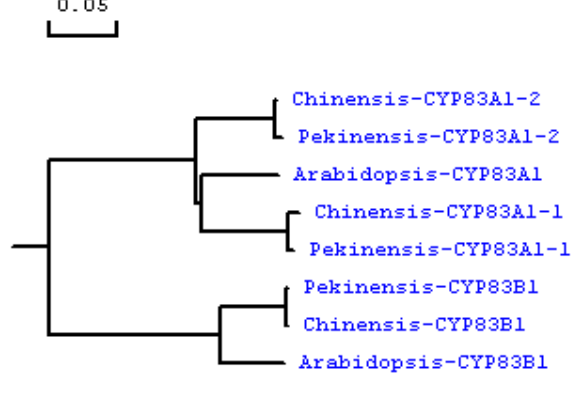
Figure 3. Phylogenetic tree of the cDNA sequences of the plant glycosyltransferase superfamily. GenBank accession numbers are: Arabidopsis thaliana CYP83A1 (NM117451), Arabidopsis thaliana CYP83B1 (NM119299), Brassica pekinensis CYP83A1-1 and CYP83A1-2 (FJ376049, FJ376050), Brassica pekinensis CYP83B1 (FJ376051), Brassica chinensis CYP83A1-1 and CYP83A1-2 (JQ289997, JQ289996), Brassica